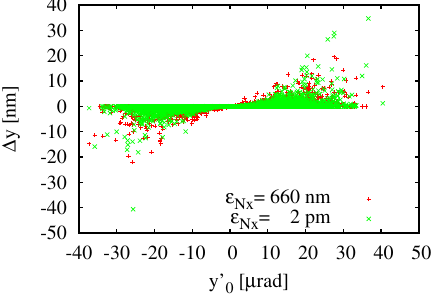
FIG. 6. Correlation between the phase space coordinates Δ y; y 0 for CLIC 3 TeV from particle tracking with two different horizontal